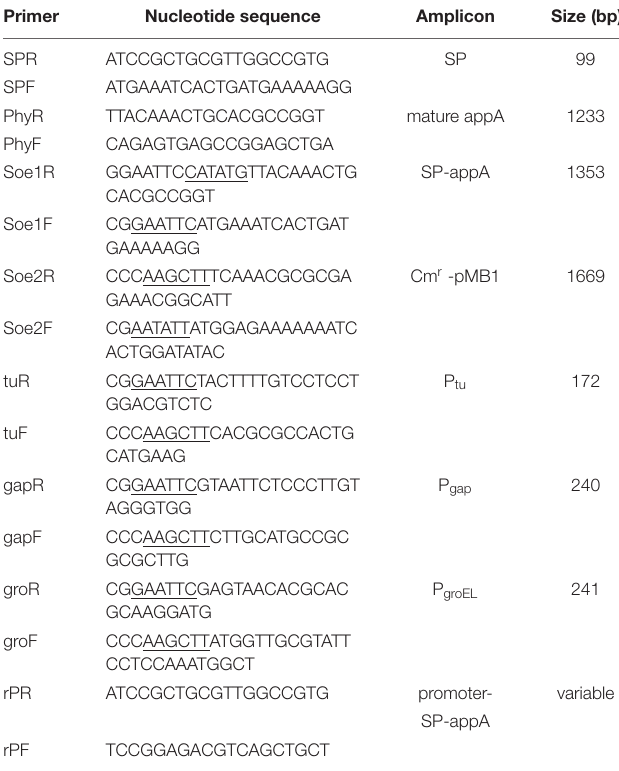
TABLE 2 | Primers used in this